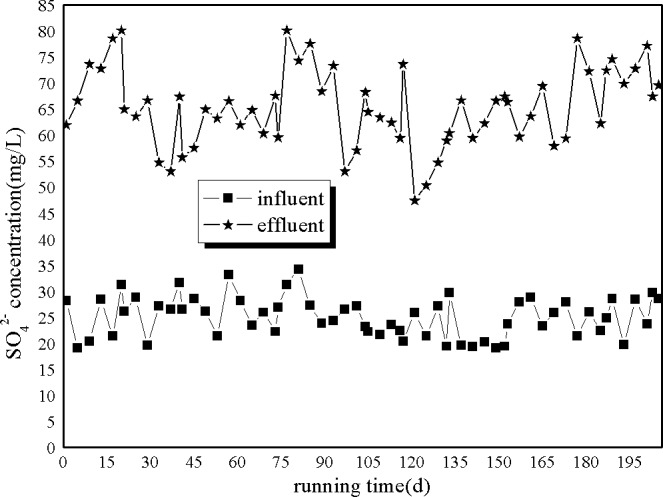
Removal of SO42- by A/O processes.